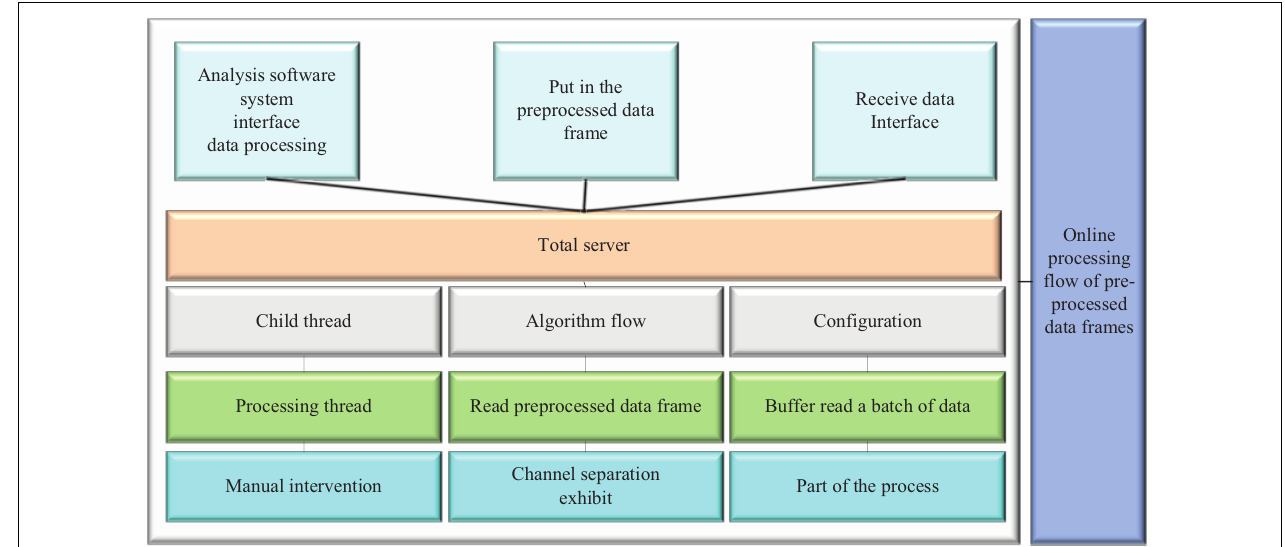
FIGURE 4 | Online processing flow of pre-processed data frames.